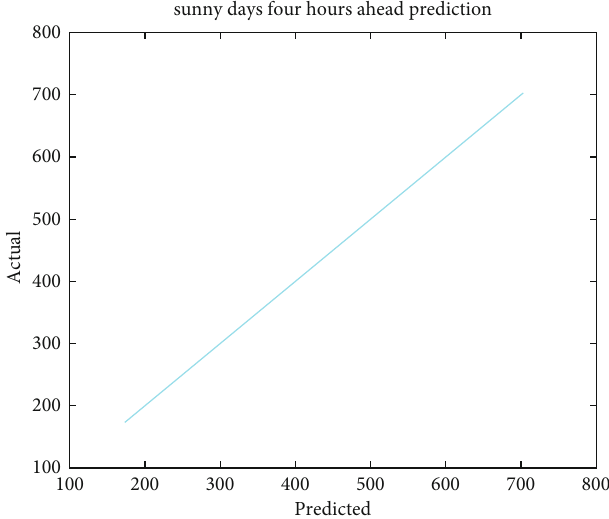
Figure 15: Relationship between actual vs. predicted solar irradiance for sunny day four-hour-ahead